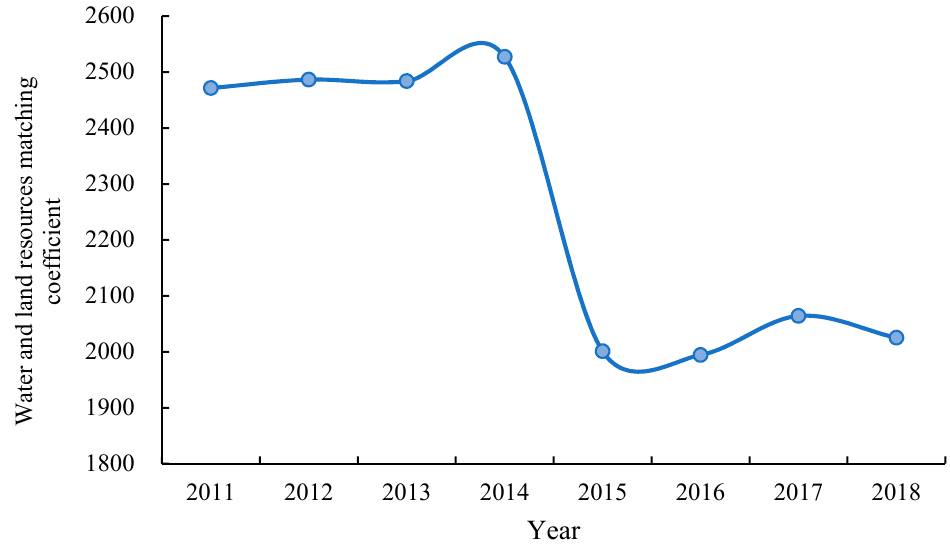
Figure 4. Change trend of water and land resources matching coefficient from 2011 to 2018.